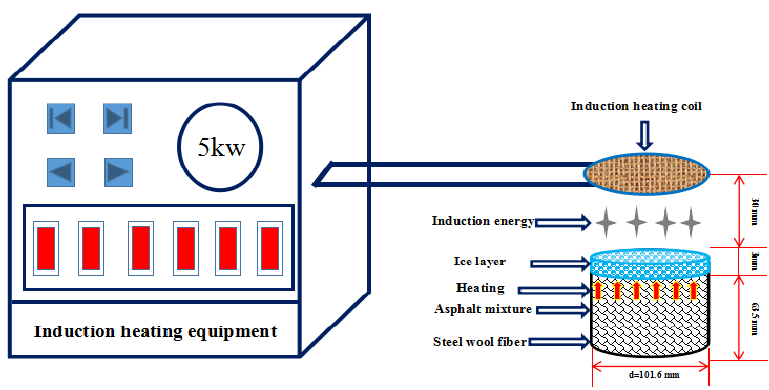
Figure 8. The diagram of experimental heating and deicing process.